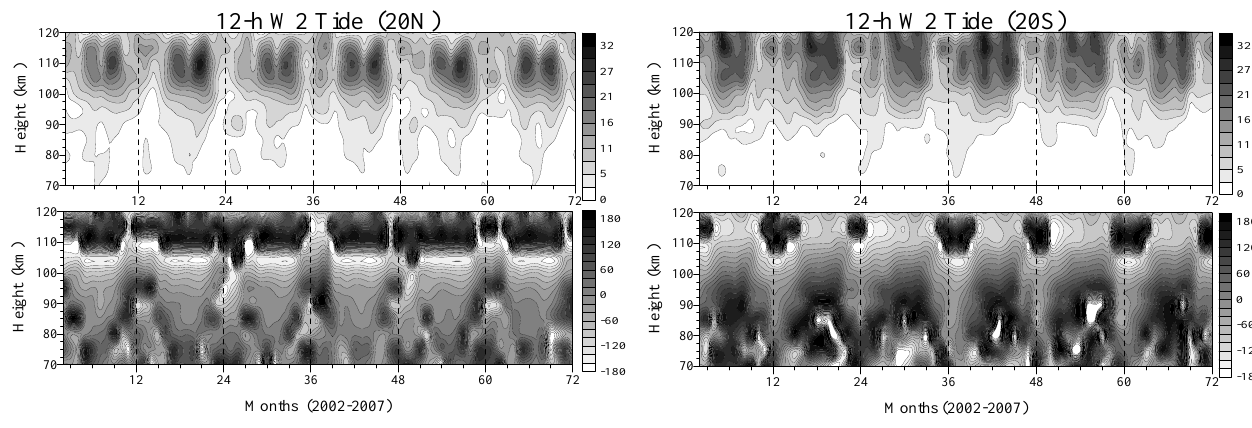
Fig. 5. Altitude-time cross sections of the tidal amplitudes (upper row of plots) and phases (bottom row of plots) observed at 20 ◦ N (left Figure 5 column of plots) and 20 ◦ S (right column of